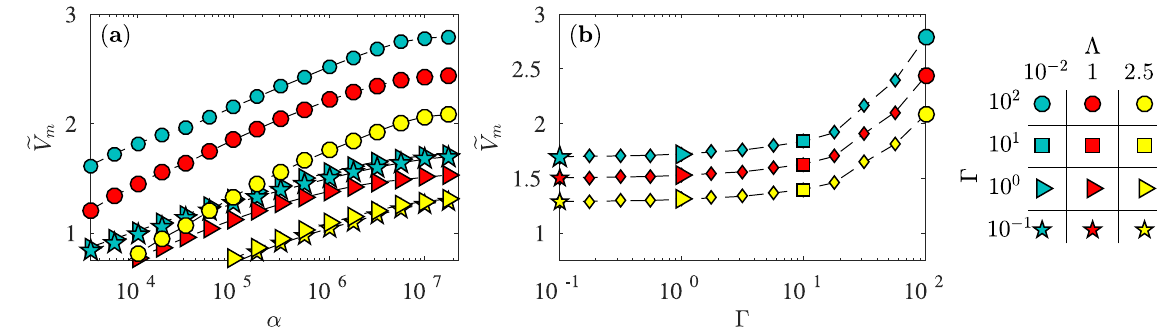
Figure 7. Panel (a) : asymptotic behavior for τ (cid:29) 1 where we expect a limiting behavior of e V m = e g((cid:51),(cid:48)) for α (cid:29) 1; see Eq. (46). Con- vergence to constant values confirms the limiting behavior. Note that α is plotted on a logarithmic scale. Panel (b) : velocities against (cid:48) = τ − (n + 1 ) α at constant values of (cid:51) = Pe 1 /( 1 + β) α − 1 as indicated by color and α = 10 7 . 25 . Note that (cid:48) → 0 corresponds to τ → ∞ , the limit without subtemperate